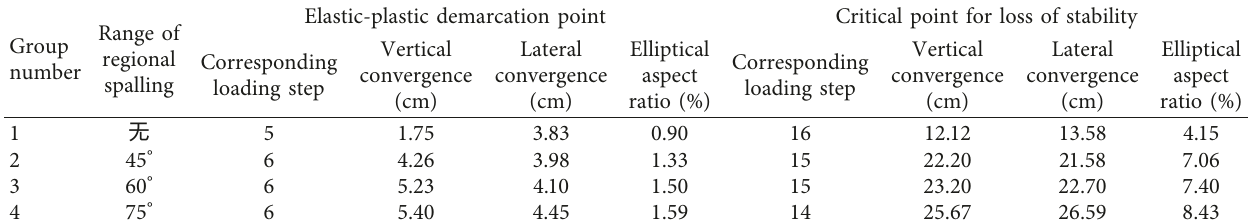
Table 8: Deformation of each group of